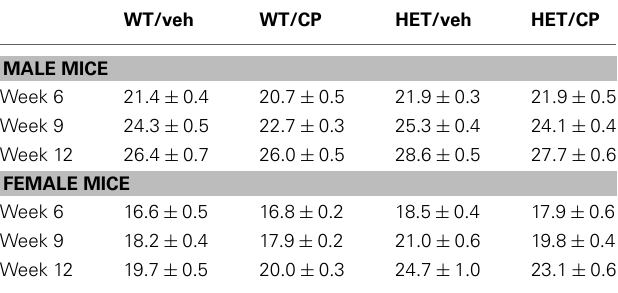
heterozygous (HET) mice treated with vehicle (veh) or CP55,940 (CP) at 6 weeks (beginning of drug treatment), 9 weeks (end of drug treatment), and 12 weeks of age (during behavioral testing).